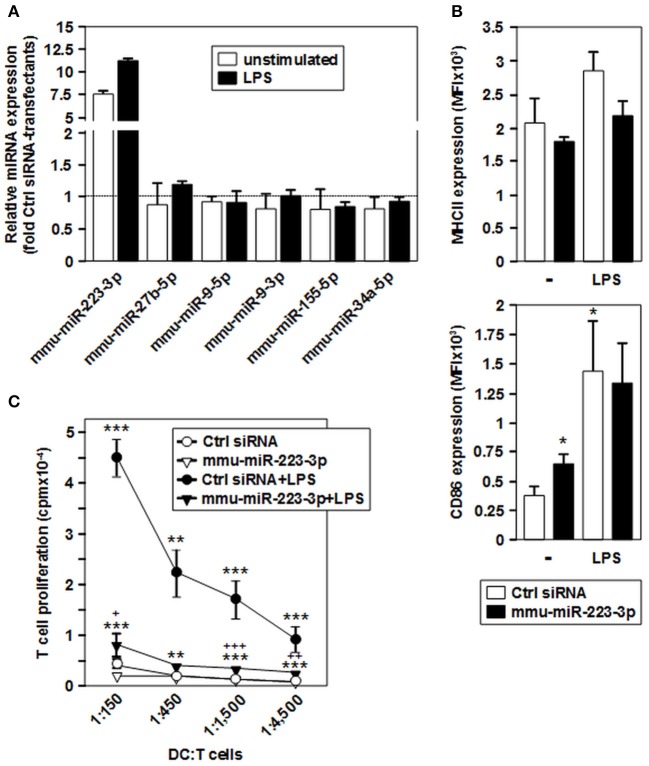
Overexpression of mmu-miR-223-3p in BMDCs prevents stimulation-induced upregulation of MHCII and the acquisition of potent T cell stimulatory capacity. iDCs were transfected with a mmu-miR-223-3p mimick or a scrambled siRNA as a control, and aliquots were stimulated with LPS. (A) Relative expression levels of mmu-miR-223-3p and other miRNA species in mmu-miR-223-3p-transfected BMDC populations as compared with Ctrl sirRNA-transfectants were assessed by real time PCR analysis. Data indicate the mean ± SD of 2 independent experiments performed in duplicate. (B) Surface expression of MHCII (upper panel) and CD86 (lower panel) in differentially transfected BMDCs at either state of activation was monitored by flow cytometry. Data indicate the mean fluorescence intensity (MFI) ±SEM of 5 independent experiments each. (C) Differentially transfected BMDC populations were titrated (starting concentration: 2 × 105/ml) and cocultured with allogeneic T cells (each 3 × 106/ml) in triplicates at the indicated ratios for 4 days. Data indicate T cell proliferation quantitated as cpm due to genomic incorporation of 3H-thymidine applied for the last 16–18 h of coculture, and denote the mean ± SEM of 5 independent experiments performed in triplicate. (B,C) Statistically significant differences: *vs. Ctrl siRNA, and + vs. mmu-miR-223-3p transfected BMDC at unstimulated state (*, +p < 0.05, **, ++p < 0.01, ***, +++p < 0.001).